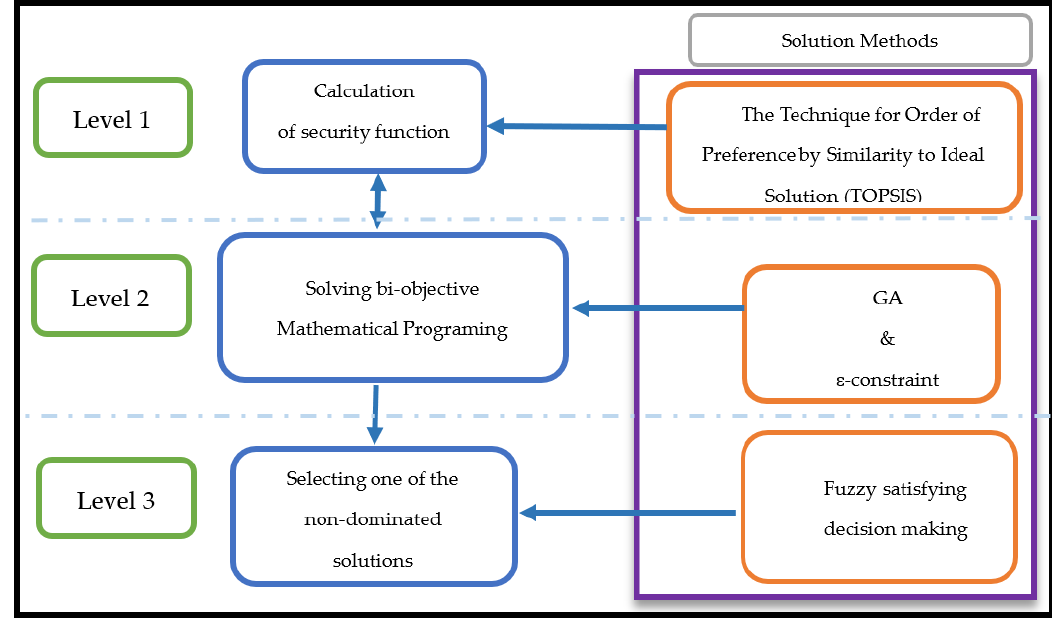
Figure 3. Decision making